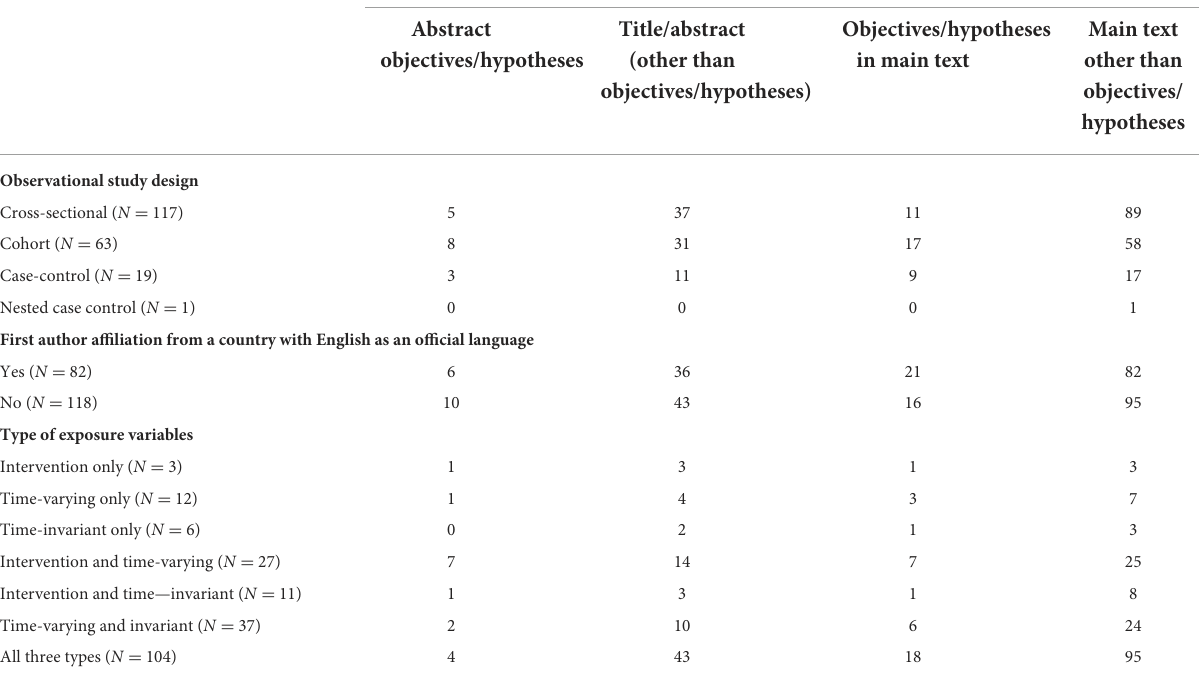
TABLE 5 Use of causal wording by study design, type of exposures examined, and whether the first author affiliation was from a country in which English is an official